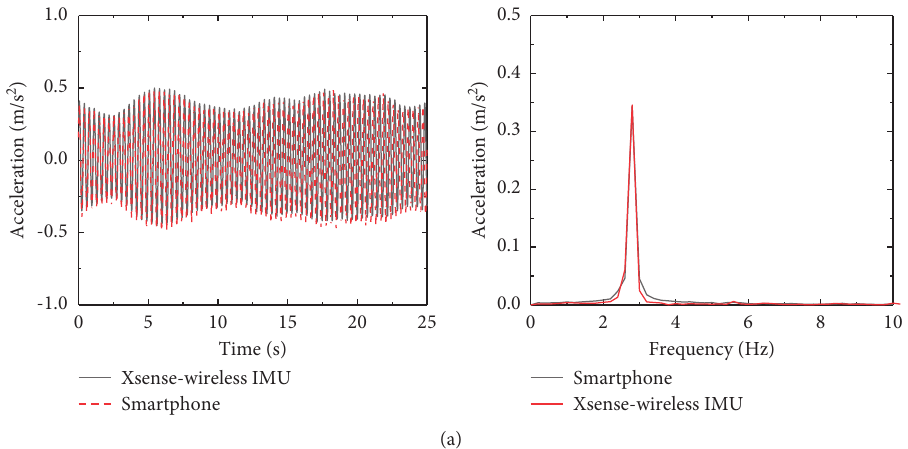
Figure 16: Comparison of human body acceleration (lower back) obtained from wireless IMU and smartphone (iPhone 7 plus). (a) Time domain and (b) frequency